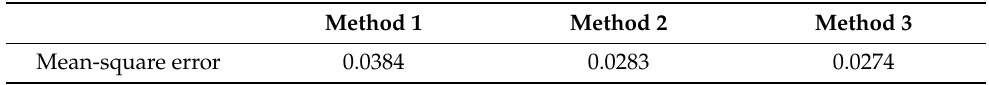
Table 1. The mean-square error of the relative errors (400–1400